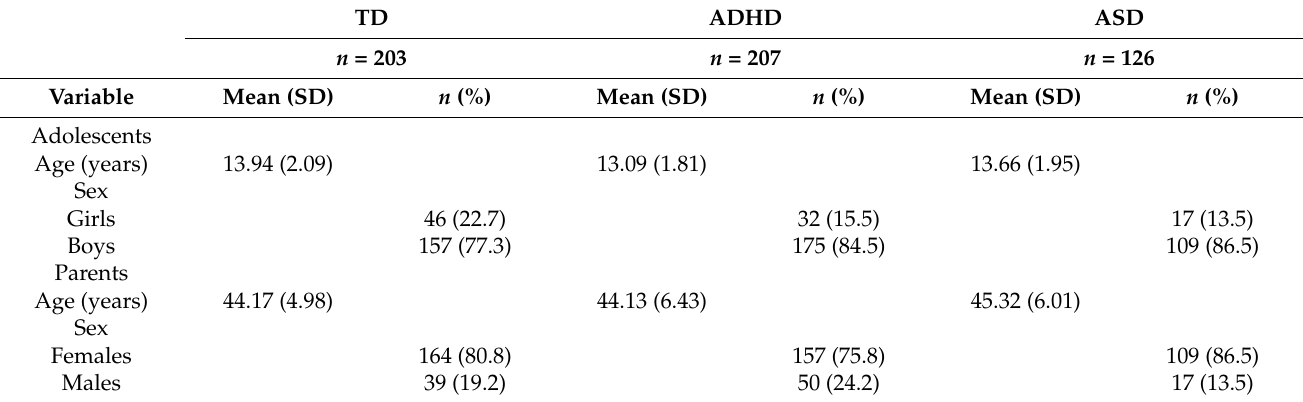
Table 1. Adolescent and Parent Sex and Age Distributions in TD, ADHD, and ASD Groups. TD ADHD